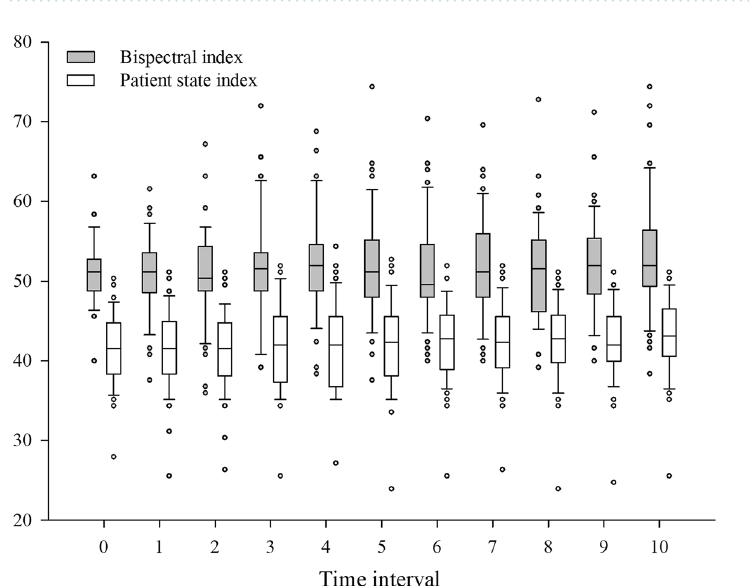
Table 2. Comparison of data before and after administration of sugammadex. Data expressed as median [IQR]. *The P value for the baseline vs. BIS and PSI values at the time of TOFR ≥ 0.9 **The P value for the baseline vs. Maximal BIS and PSI values. TOFR 0.9 Train of four ratio of 0.9, BIS bispectral index, PSI patient state index, BIS-EMG electromyography recorded by the BIS electrode, PSI-EMG EMG recorded by the PSI electrode.